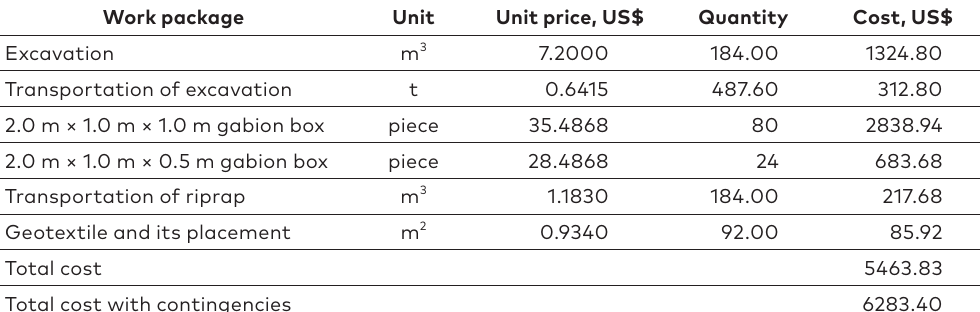
Table 6. Unit prices and costs of the gabion